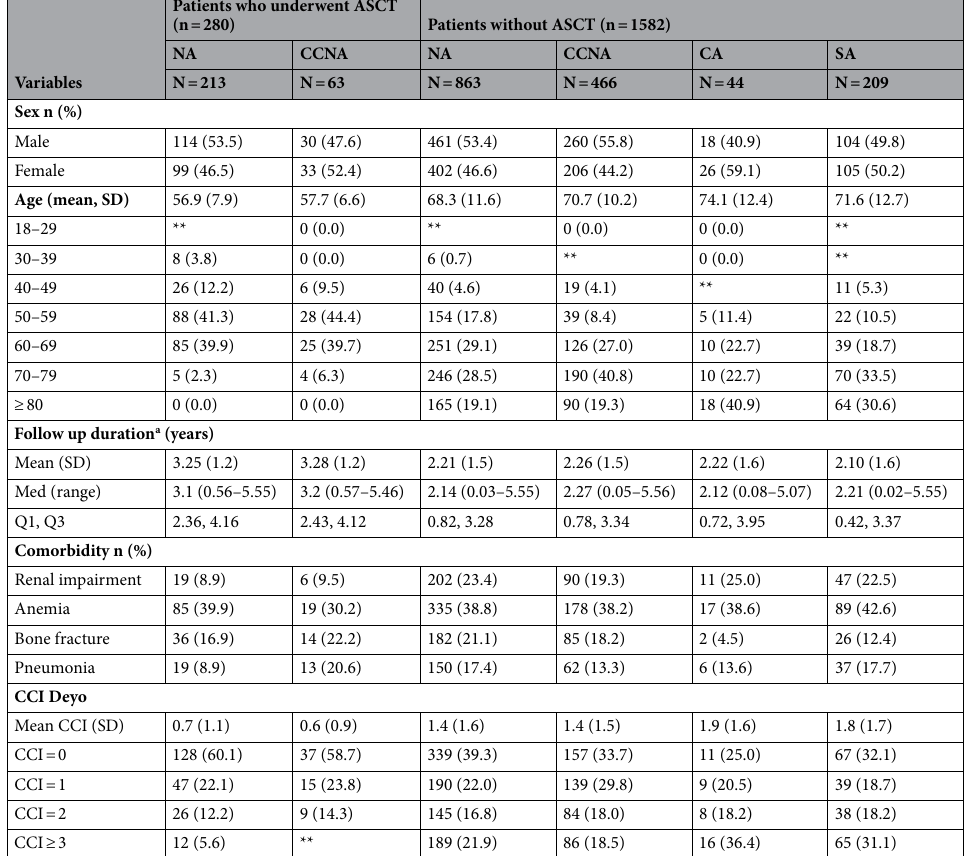
Table 1. Demographic, clinical characteristics and follow-up duration of patients with treated MM diagnosed in the post-bortezomib period (1 June 2012 until 31 Dec 2015) by ASCT status and first-line treatment. ASCT autologous stem cell transplantation, CCI Charlson co-morbidity index, SD standard deviation, Q1/Q3 inter-quartile range, NA novel agents (thalidomide or bortezomib) alone, CCNA chemotherapy (melphalan cyclophosphamide, vincristine, other chemotherapy regimens) combined with novel agents, CA chemotherapy alone, SA steroids alone. a From diagnosis date to censor (31 Dec 2017) or death; **To protect patient privacy, all non-zero counts that were less than three were suppressed, including 4 ASCT recipients who received first- line CA or